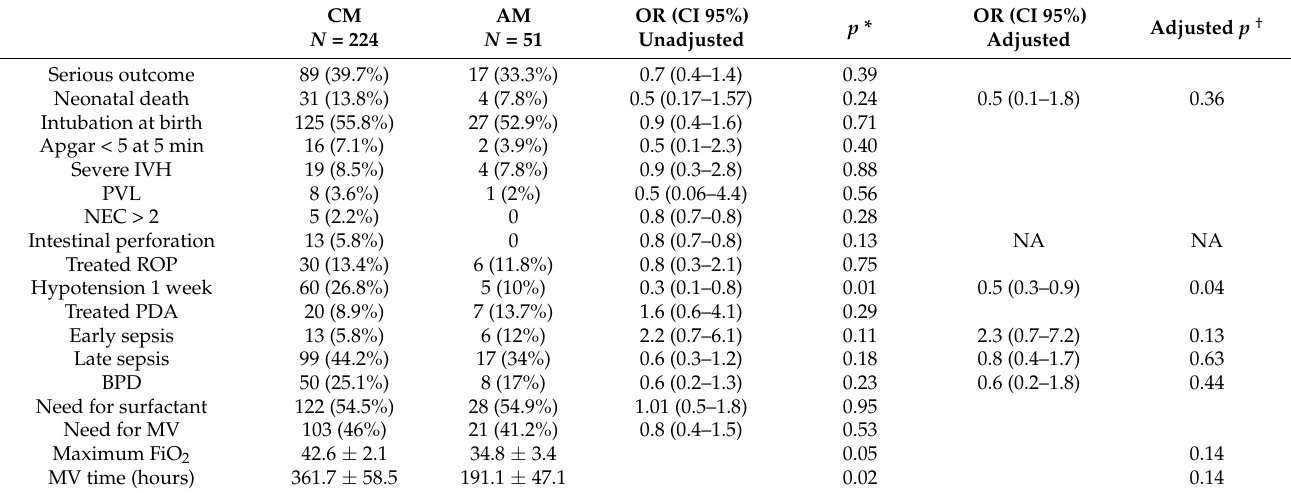
Table 2. Results of the cohort comparison by prenatal corticosteroid inter-dose interval.